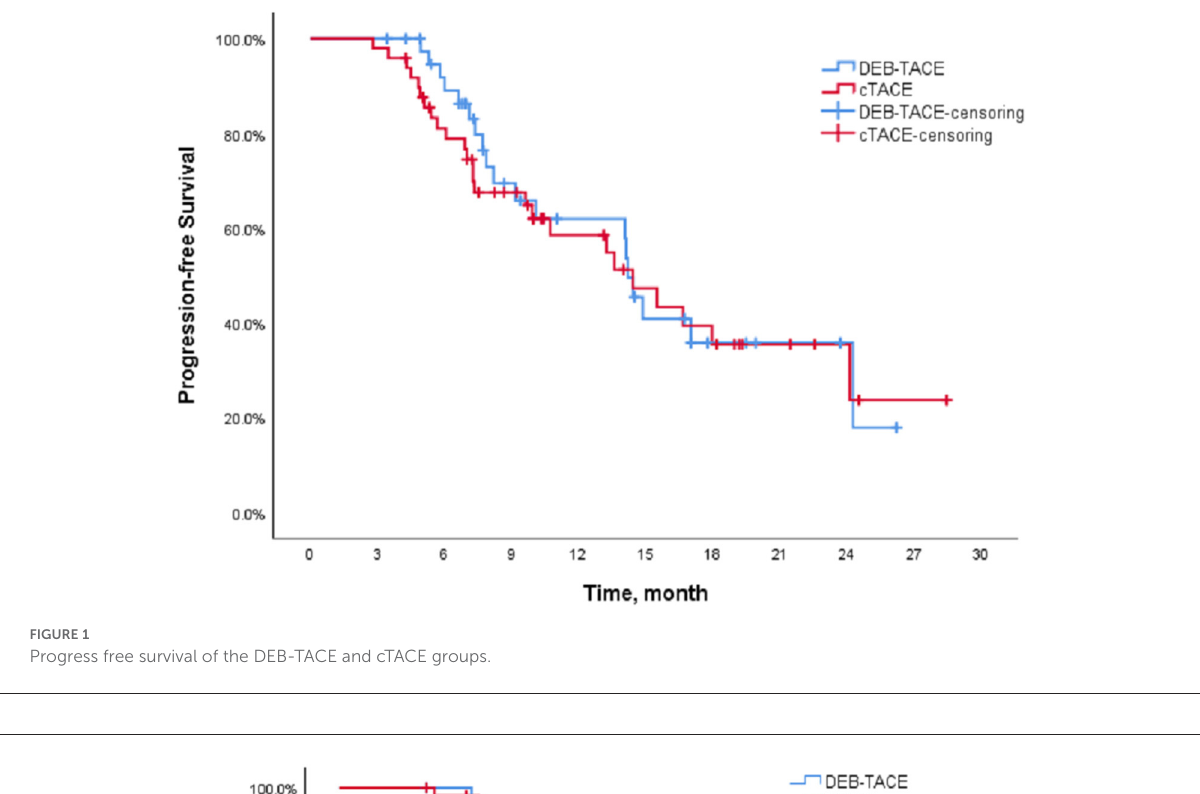
FIGURE1 Progress free survival of the DEB-TACE and cTACE groups.